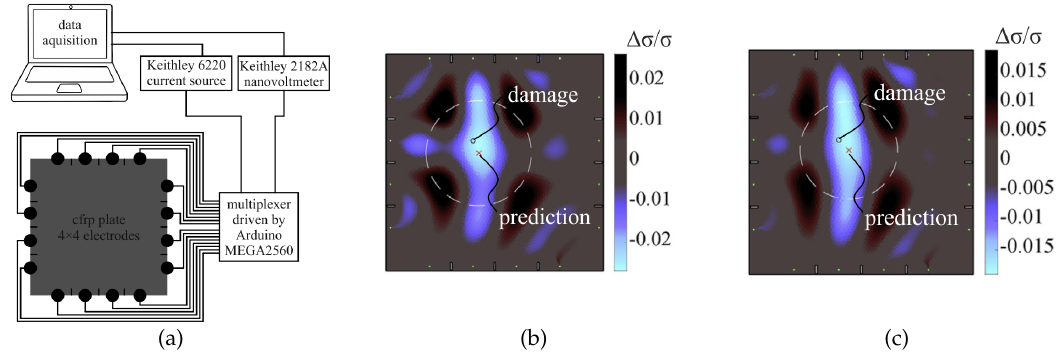
Figure 5. ( a ) Experimental setup: pristine plate with rivet-electrodes and measurement devices. ( b ) Reconstructed conductivity change from measurement for diagonal current injection pattern and a hyperparameter λ = 0.0029. ( c ) Reconstructed conductivity change from 3D numerical simulation for diagonal current injection pattern and a hyperparameter λ = 0.0029. The circle indicates the defect position (5-mm hole). The red cross is the center of gravity of the minimum one-forth amplitude set (white circle)